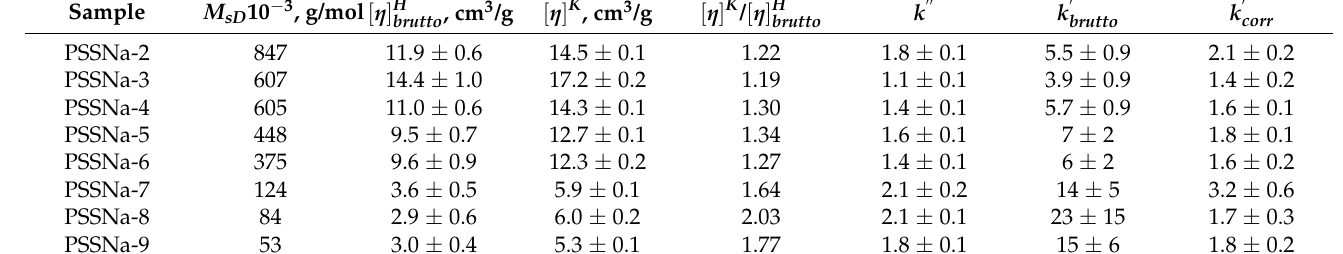
Table 2. The molecular masses M sD , the values of intrinsic viscosities, obtained from Huggins ( [ η ] H ) and Kraemer ( [ η ] K ) plots and Kraemer ( k (cid:48)(cid:48) ) and Huggins ( k ’ brutto PSSNa in aqueous 4.17 M NaCl solutions at 25 ◦ C.